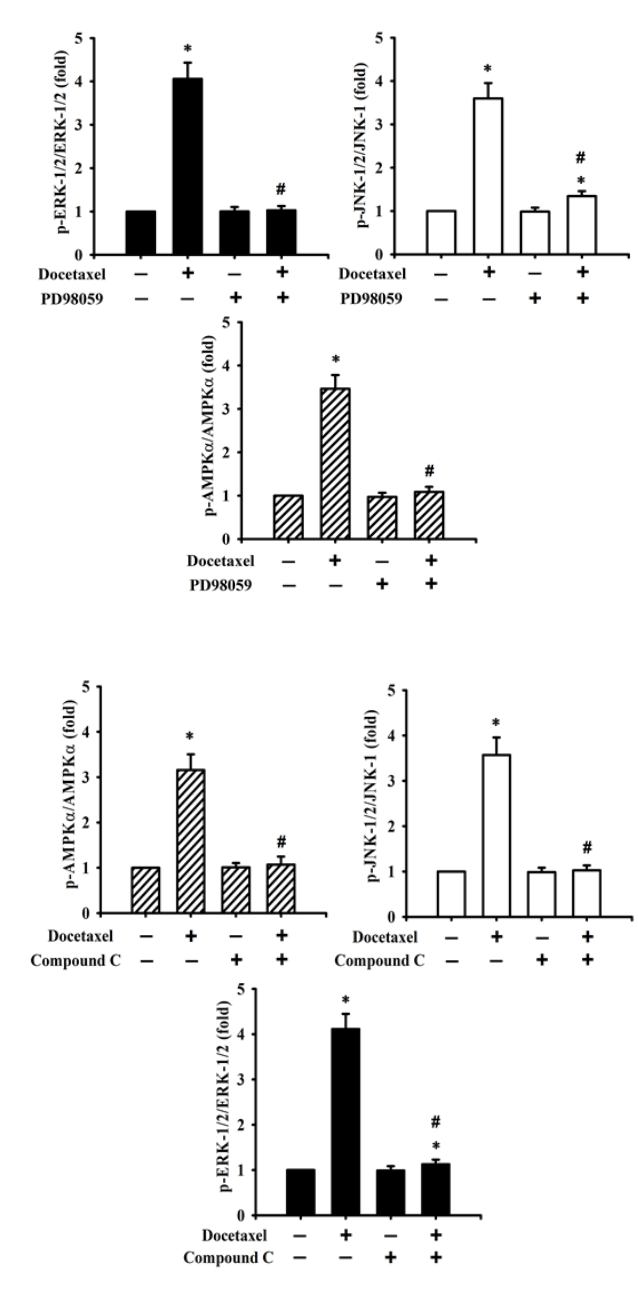
Figure 5. The interaction of ERK, JNK, and AMPK signals in human tongue squamous carcinoma- derived SAS cells. Cells were pretreated with ( A ) SP600125 (a JNK inhibitor; 20 μM), ( B ) PD98059 (an MEK1/2 inhibitor; 20 μM), and ( C ) compound c (an AMPK inhibitor; 10 μM) for 1 h and then treated with or without docetaxel for 8 h. The protein expression of p-JNK1/2, p-ERK1/2, and p-AMPK α was determined by Western blot analysis. Results are shown in ( A , B, and C ) of representative images, and quantification was performed by densitometric analysis. Each presented bar is the mean ± SD of three independent experiments. Statistical analysis was performed with one-way ANOVA analysis followed by Tukey’s post hoc test. * p < 0.05 compared with vehicle control. # p < 0.05 compared with docetaxel treatment group.